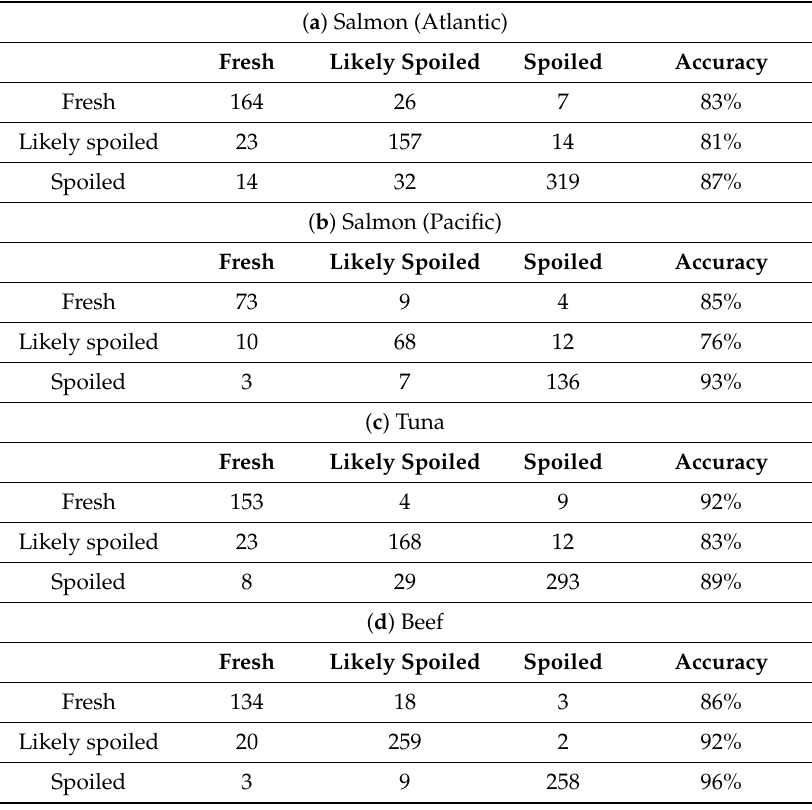
Table 3. Confusion matrices of the machine learning models using the independently collected verification